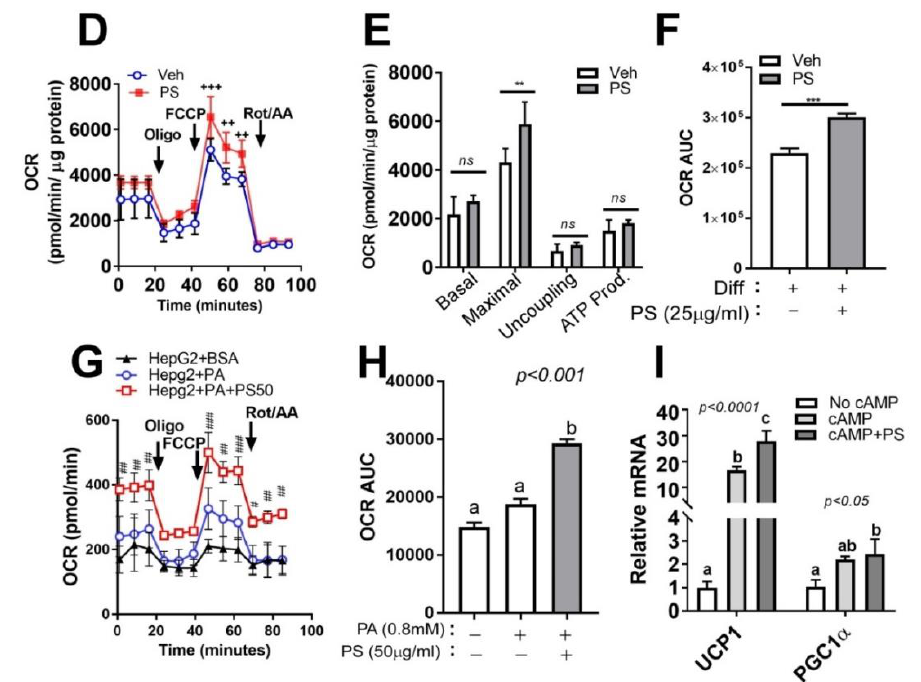
Figure 4. PSE attenuates lipid accumulation in cultures of adipocytes by upregulating fatty acid oxidation and mitochondrial oxygen consumption. ( A ) Experimental scheme. 3T3-L1 were seeded on the second day before differentiation ( d-2 ) and induced to differentiation ( d0 , MDI: methyl isobutyl- xanthine, dexamethasone, and insulin). Keep 3T3-L1 cells differentiated into fully differentiated adipocytes until d7. Fully differentiated adipocytes ( d7 ) were incubated with PSE (25 µ g/mL) for three days. ( B ) Lipogenic and fatty acid oxidation-related gene expression of PPAR γ , aP2, PGC1 α , CPT1, and PPAR α as determined by qPCR. ( C ) Conversion of [ 3 H]-OA into [ 3 H]-H 2 O. ( D – F ) Oxygen consumption rate (OCR) in 3T3-L1 adipocytes treated with Veh (blue) and PSE (red) as determined by Seahorse extracellular analyzer. 3T3-L1 cells differentiated into fully differentiated adipocytes. Fully differentiated adipocytes ( d7 ) were incubated with PSE (25 µ g/mL) for one day. Arrow indicates the addition of respiratory inhibitors of oligomycin (Oligo), carbonyl cyanide 4-trifluoromethoxy phenylhydrazone (FCCP) and a combination of antimycin A and rotenone (Rot/AA). ( G – H ) OCR in HepG2 cells treated with BSA (black), PA (blue), and PA + PSE (red) as determined by Seahorse extracellular analyzer. HepG2 cells were pre-incubated with PSE (50 µ g/mL)for 48 h. BSA or 0.8 mM BSA-PA complex was loaded for 3 h. (I) Relative expressions of UCP1 and PGC1 α by qPCR. Pre-treatment of the 3T3-L1 cell with PSE for 7 d during adipogenesis, followed by Bt2-cAMP stimulation for 6 h. All values are presented as the mean ± SEM. n.s. represents no significance. * p < 0.05; ** p < 0.01; *** p < 0.001 compared with the vehicle control (DMSO-treated cells) by Student’s t -test or one-way ANOVA with Bonferroni’s comparison test. Means that do not share a common superscript are significantly different as determined by one-way ANOVA with Bonferroni’s comparison test. ++ p < 0.01; +++ p < 0.001 compared with the vehicle control (DMSO treated cells) # p < 0.05; ## p < 0.01; ### p < 0.001 compared with PA-treated HepG2 cells by two-way ANOVA with Bonferroni’s comparison test. +; treatment, -;